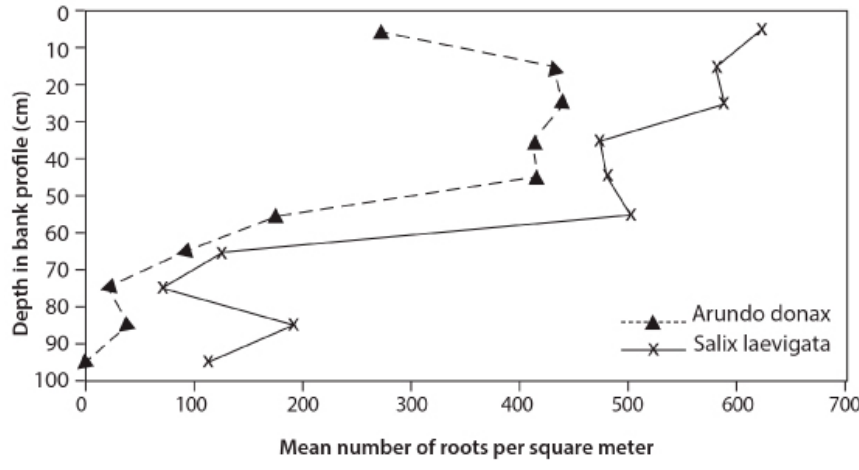
Figure 10. The mean number of roots (per square meter) for A. donax and S. laevigata at different depths in the bank profile.